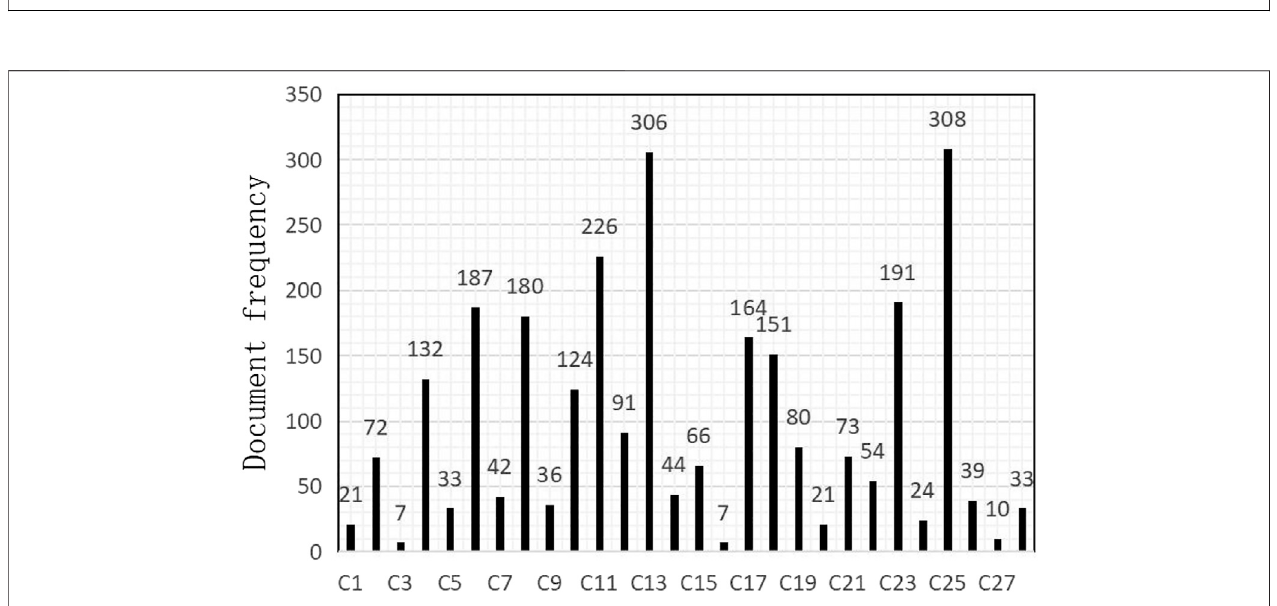
FIGURE 4 | Document frequency of the accident causal factors.